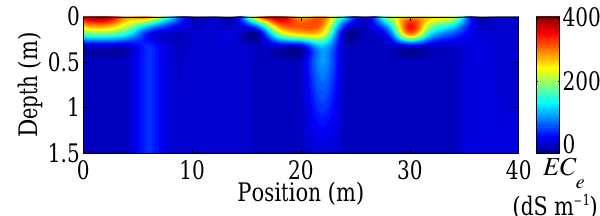
Figure 9. Spatial distribution of soil salinity (EC e ) obtained using Bayesian inversion of multi-configuration EMI measurements along a